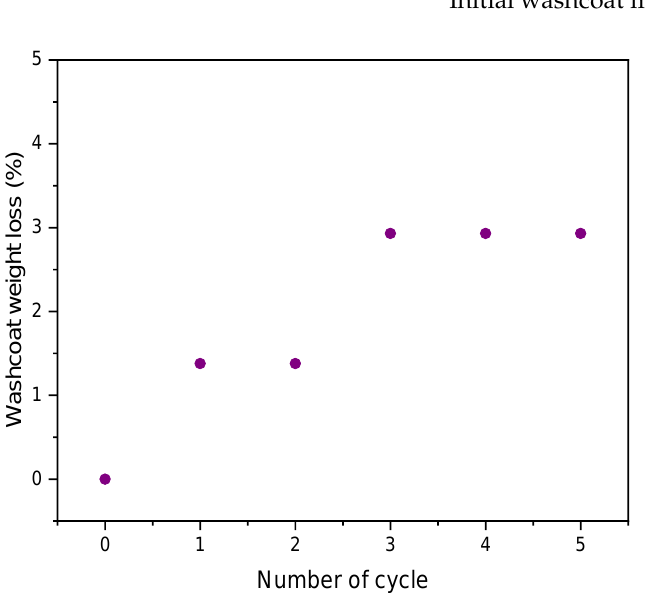
Figure 9. Ultrasound adhesion test performed on NiCoAl_C_SiC structured sample.